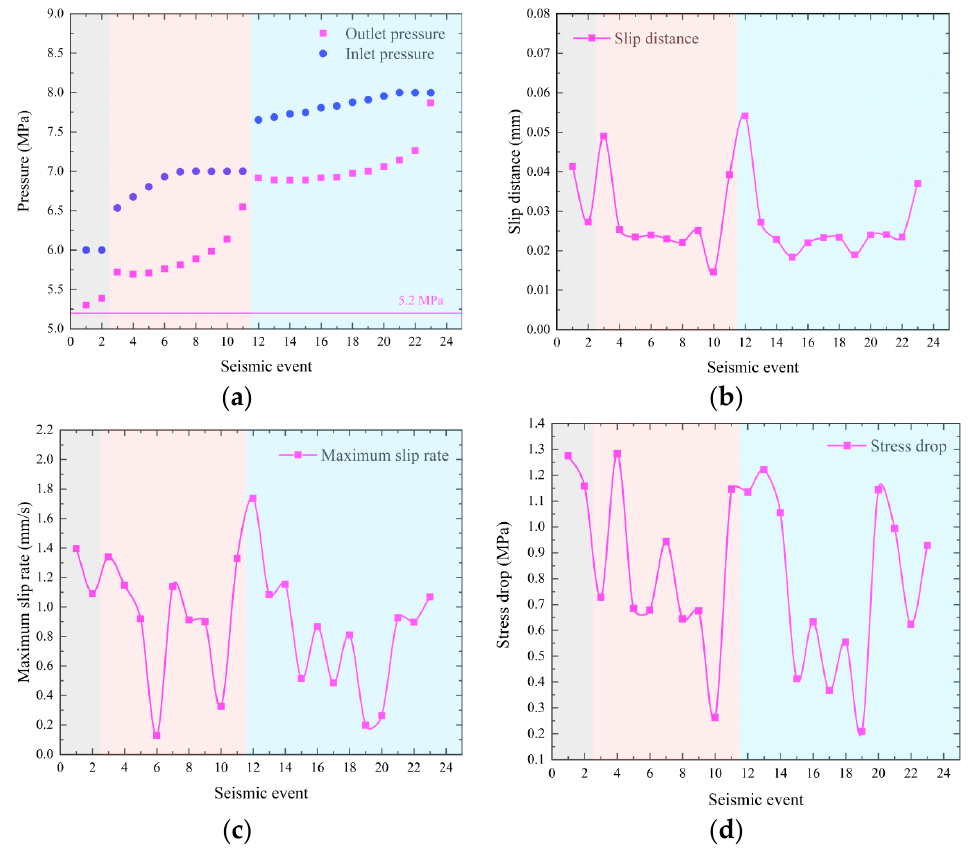
Figure 7. The dynamic slip parameters with a seismic event. ( a ) Pressure with a seismic event; ( b ) Slip distance with a seismic event; ( c ) Maximum slip rate with a seismic event; ( d ) Stress drop with a seismic